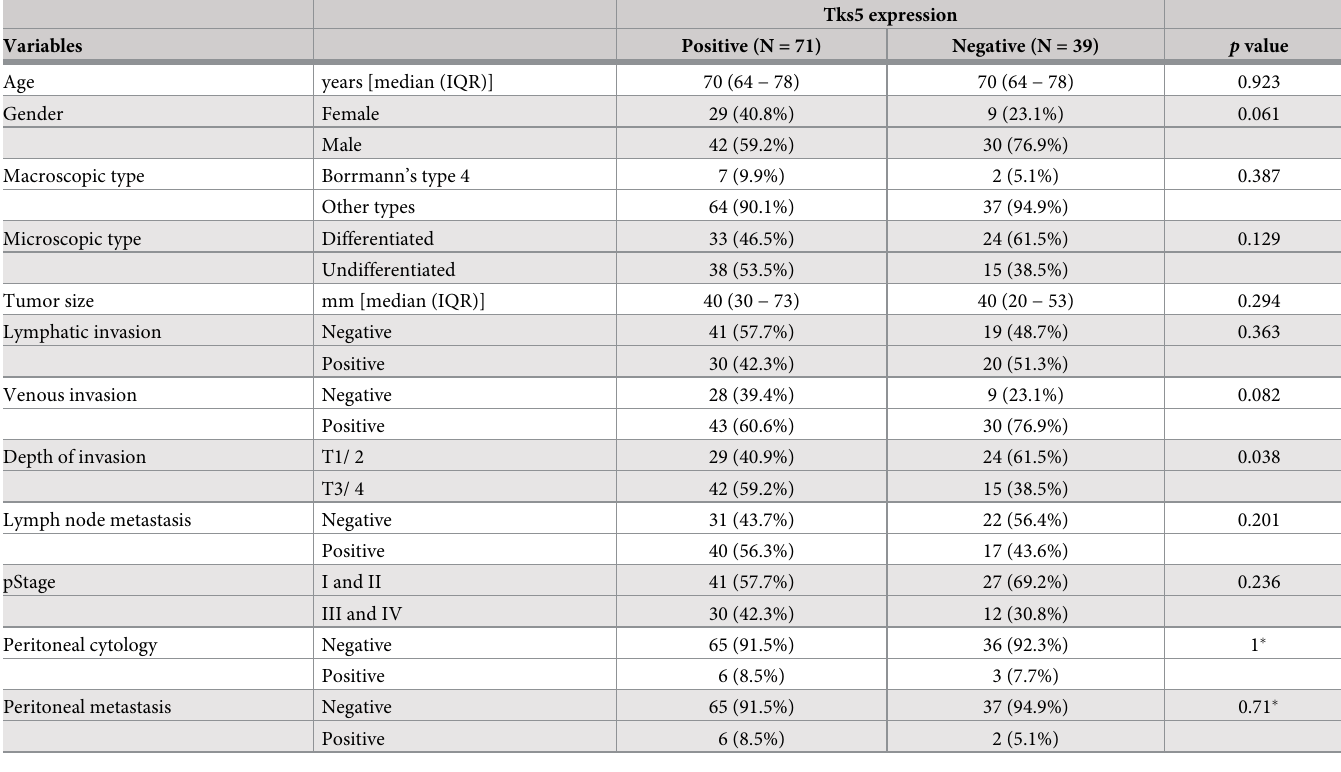
Table 1. Relationship between the Tks5 expression of peritoneal mesothelial cells and clinicopathologic features in 110 gastric cancer cases.